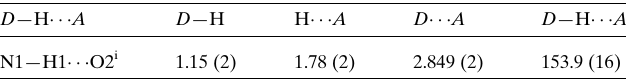
Table 1 Hydrogen-bond geometry (A˚ , (cid:2) ).